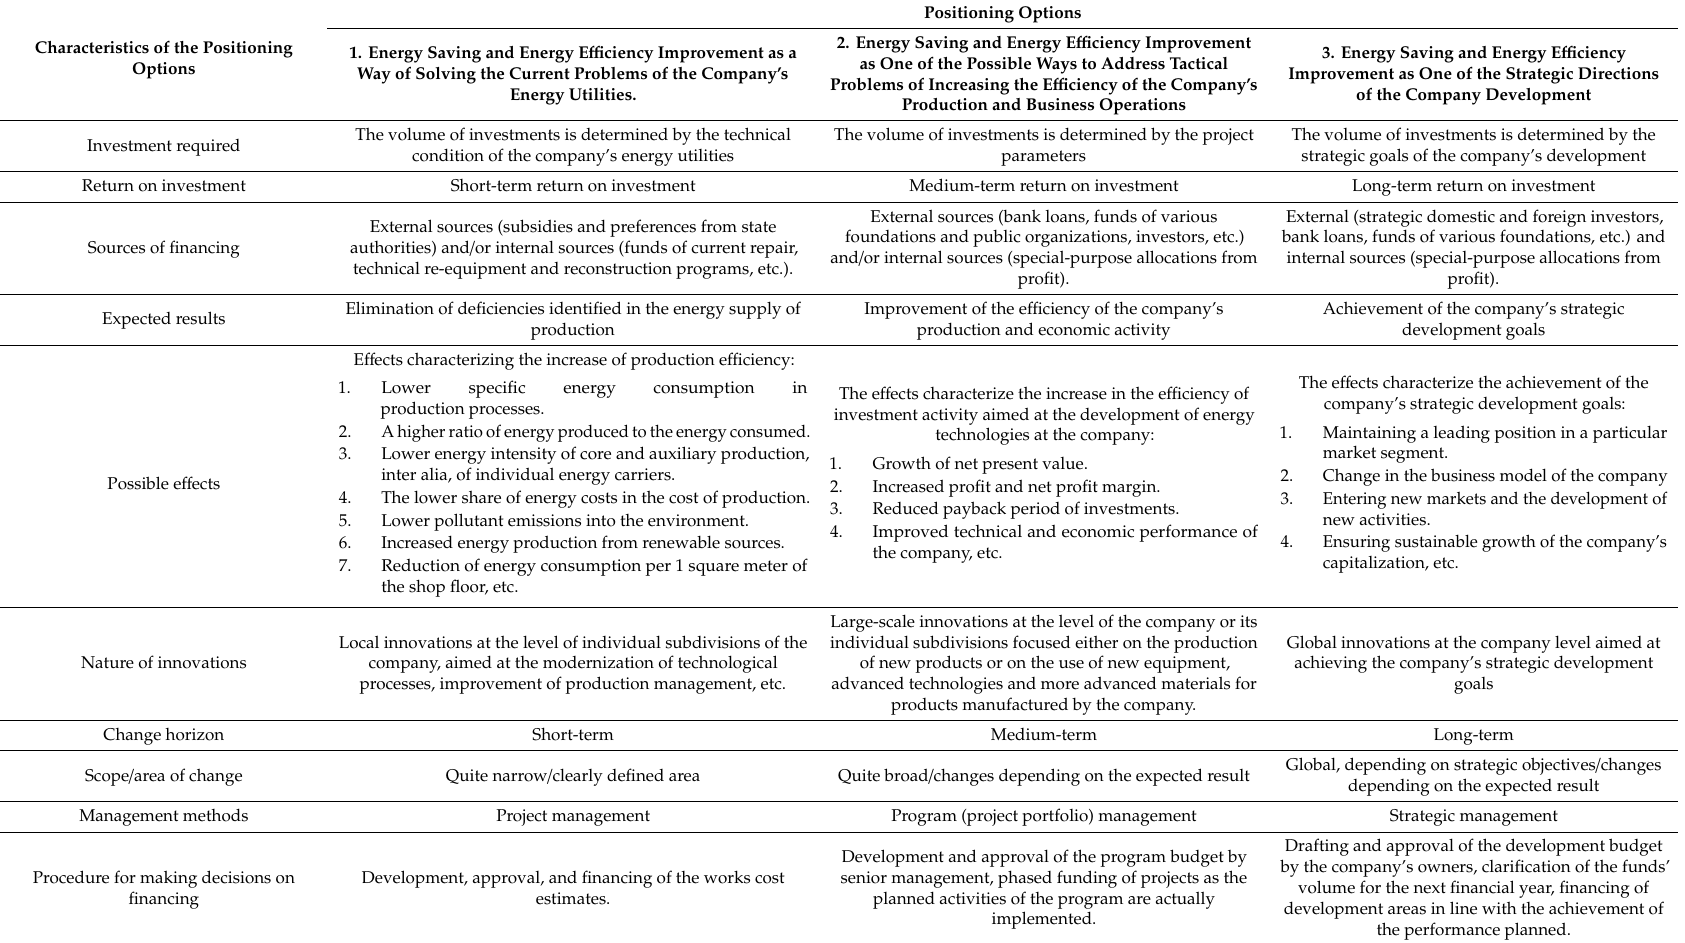
Table 1. The classifier of energy saving and energy e ffi ciency positioning options in the company (source: compiled by the